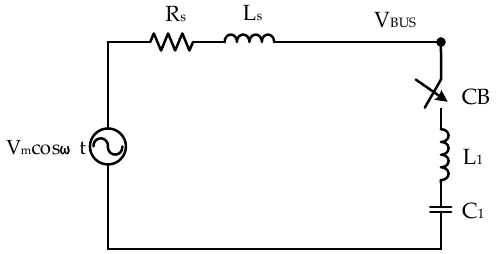
Figure 3. Equivalent circuit for single filter bank energization.